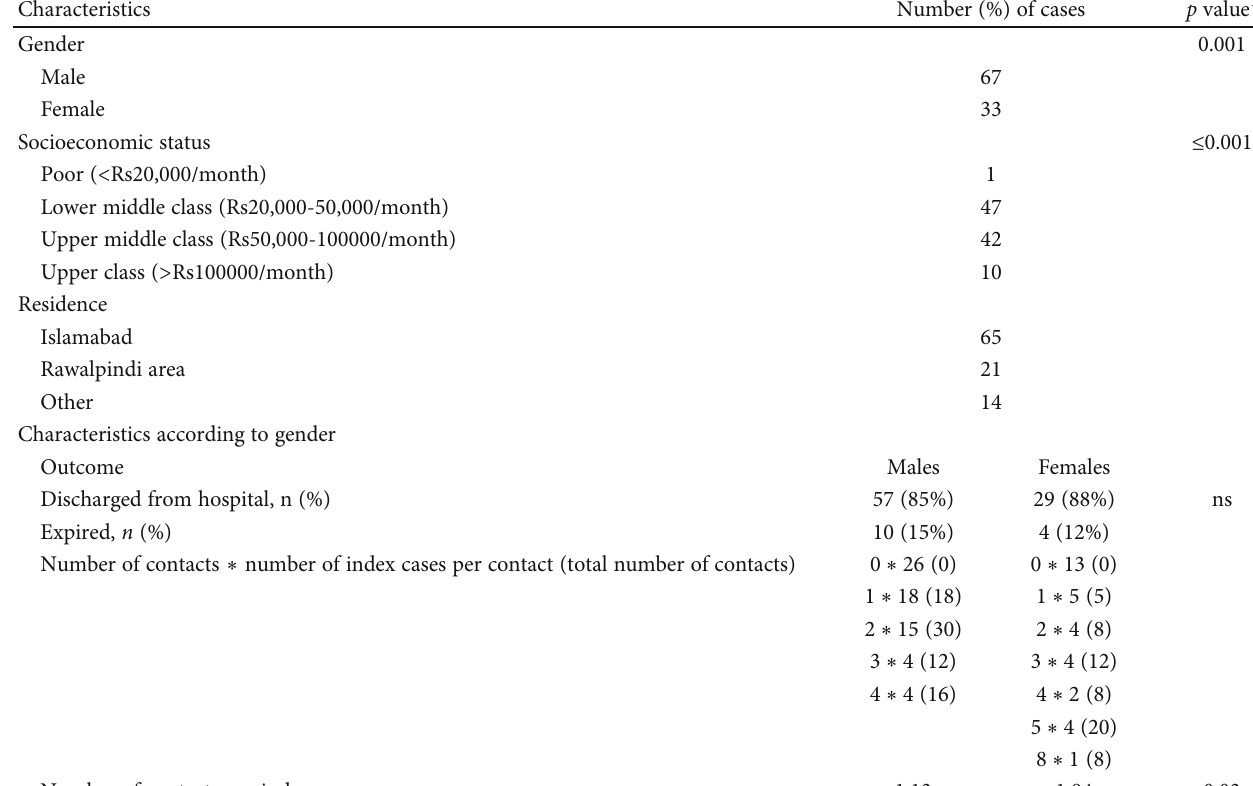
Table 1: Characteristics of the adult index cases with